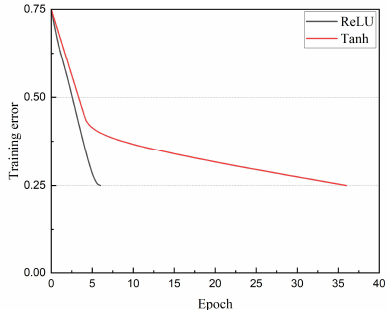
Figure 4. Comparison of network training speed using ReLU and Tanh.